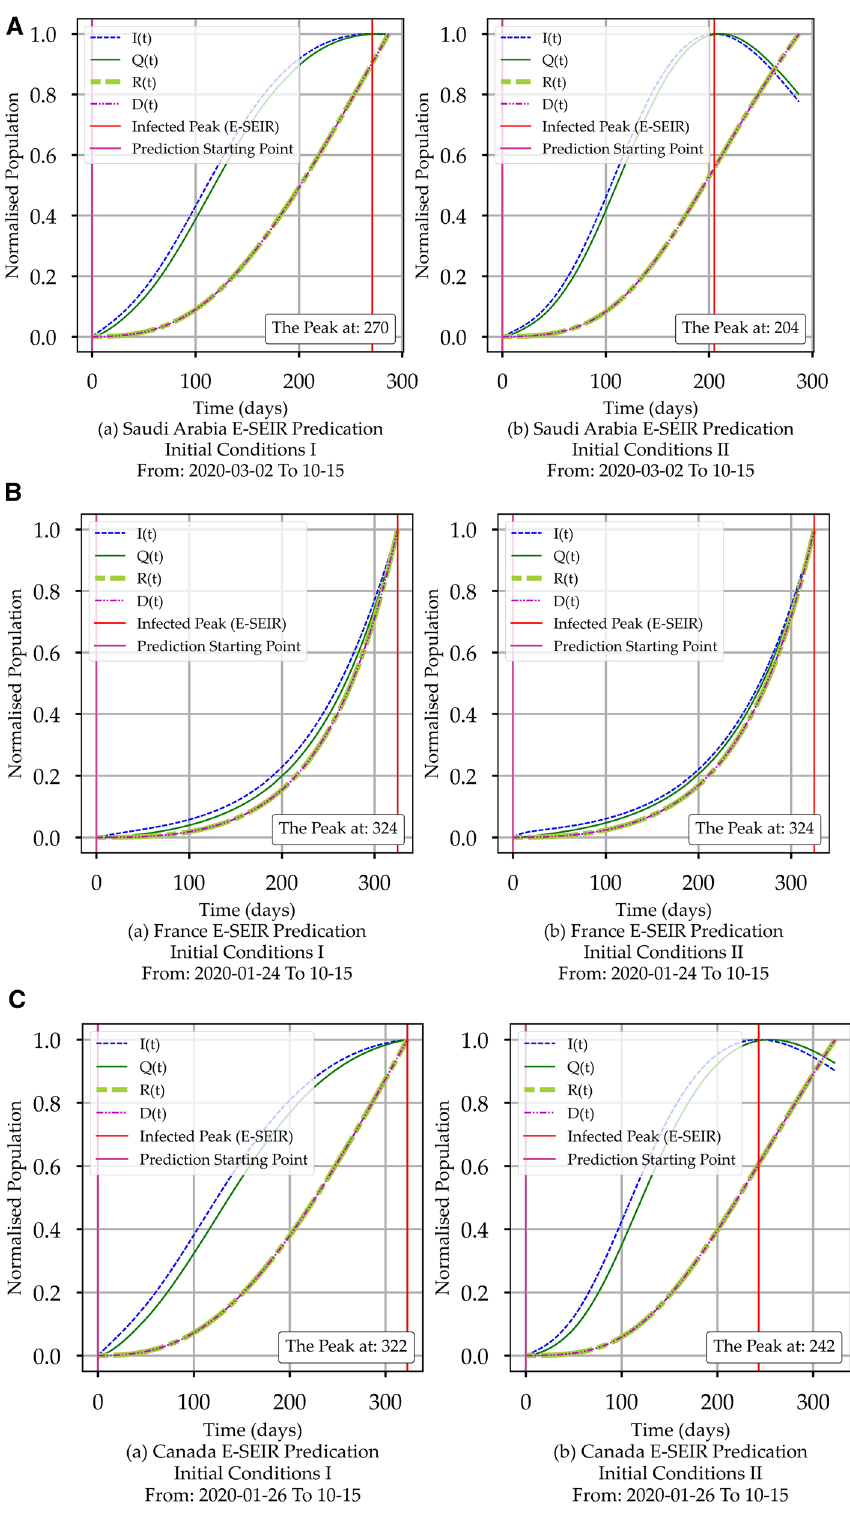
Figure 5. ( A ) The E-SEIR Model Predictions for Saudi Arabia. (a) shows the predictions associated with initial conditions set I. (b) shows the predictions related to initial conditions set II. ( B ) The E-SEIR Model Predictions for France. (a) shows the predictions associated with initial conditions set I. (b) shows the predictions associated with initial conditions set II. ( C ) The E-SEIR Model Predictions for Canada. (a) shows the predictions associated with initial conditions set I. (b), which is related to initial conditions set